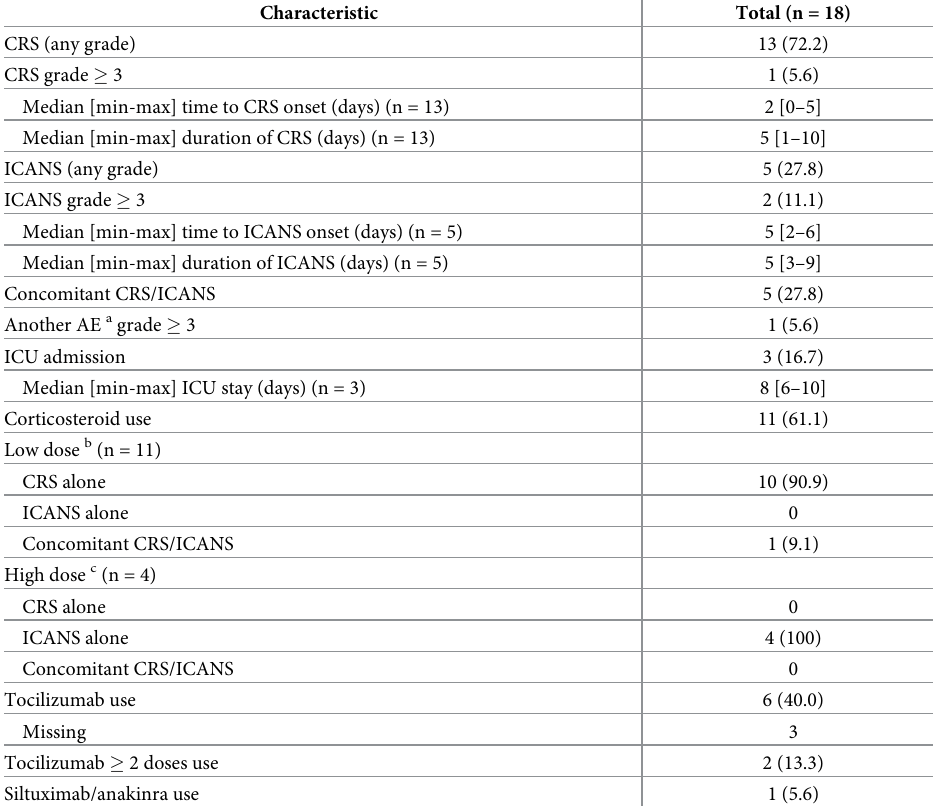
Table 3. Safety: Toxicity events, grade and treatment. Characteristic Total (n =